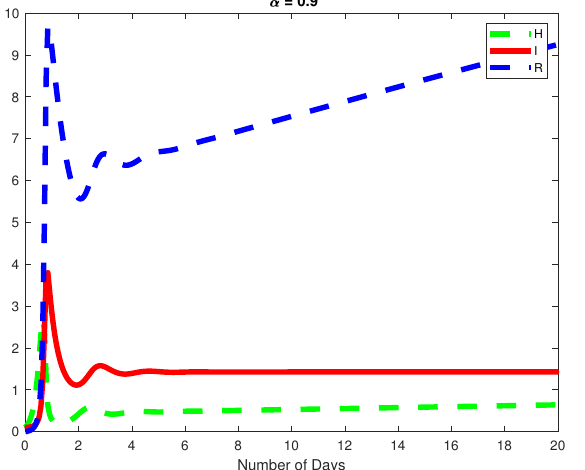
Figure 4. For the same fractional order, we plot the dynamics of the Healthy and Infected Hepatocyte as well as the Immune response cytotoxic cells for α = 0.7.